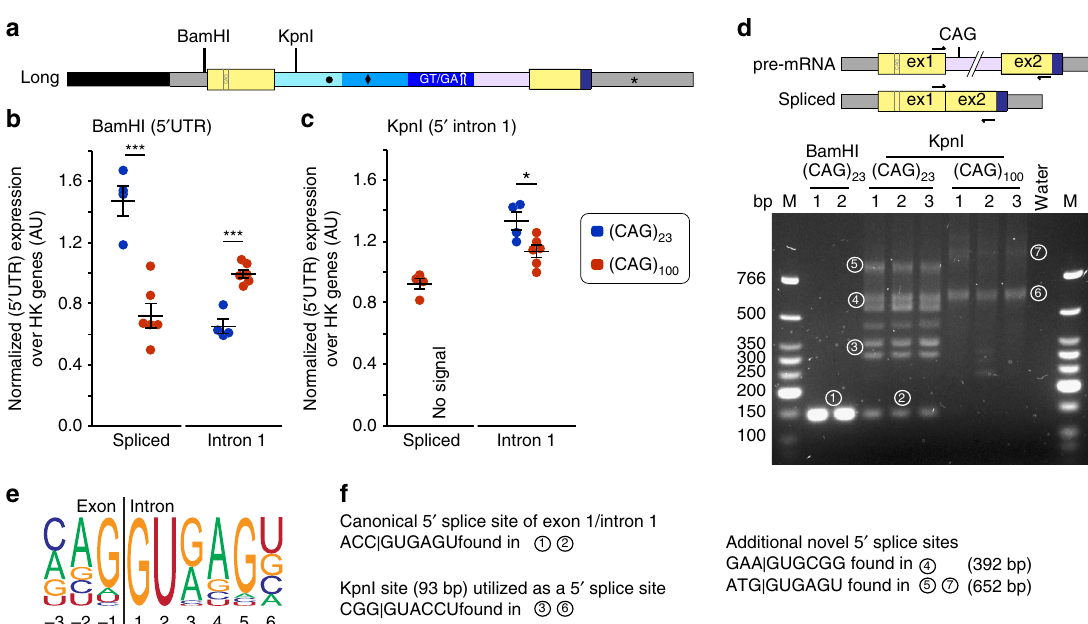
Fig. 4 The spatial relation of the CAG repeats to the 5 ′ splice site in fl uences incomplete splicing of Htt . a Schematic showing the integration sites for the CAG repeat in the (CAG) 7 long minigene backbone. Transcript analysis of BamHI ( b ) and KpnI ( c ) integrated (CAG) 23 and (CAG) 100 repeats. Individual data points and the mean ± s.e.m. are shown. n ≥ 4 independent cell lines/integration site, one-way ANOVA with Bonferroni post hoc. CAG-length: * p < 0.05, *** p < 0.001. d RT-PCR with the same primers as used in the exon 1 – exon 2-spliced qPCR assay (see Supplementary Table 2). In addition to the canonically spliced product (1), the integration of a CAG repeat at the KpnI site led to the appearance of multiple RT-PCR products (2-7). e The consensus 5 ′ splice site sequence from -3 to + 6 bp. f Novel 5 ′ splice sites that were utilized when the CAG repeat was inserted into the KpnI site. In bands 3 and 6: the 3 ′ KpnI site, used to integrate the CAG repeats, functions as a 5 ′ splice site. In bands 4, 5 and 7: sequences further downstream of the integrated CAGs in intron 1, resembling the consensus 5 ′ splice site became sequences (at about 3 kb from the exon 1/intron 1 junction). Transcript levels of 5 ′ UTR containing minigene sequences were only slightly higher in the CAG 100 compared to the CAG 7 lines (Fig. 5b, about 1.2-fold). In contrast the PolII co-precipitated 5 ′ UTR fragments were about 1.7-fold higher (Fig. 5a, p = 0.016). If we infer rate of transcription from PolII occupancy, for both CAG repeat lengths, our data suggest that PolII holoenzymes slow down after transcribing through the repeat and speed up again towards the end of intron 1 (Fig. 5a). We also observed a sig- ni fi cantly higher occupancy of PolII after the GT/GA repeats and the predicted terminator like hairpin in the (CAG) 100 line (Fig. 5a, 2.7 – 3.1 kb), indicating a slower transcriptional speed in this region.